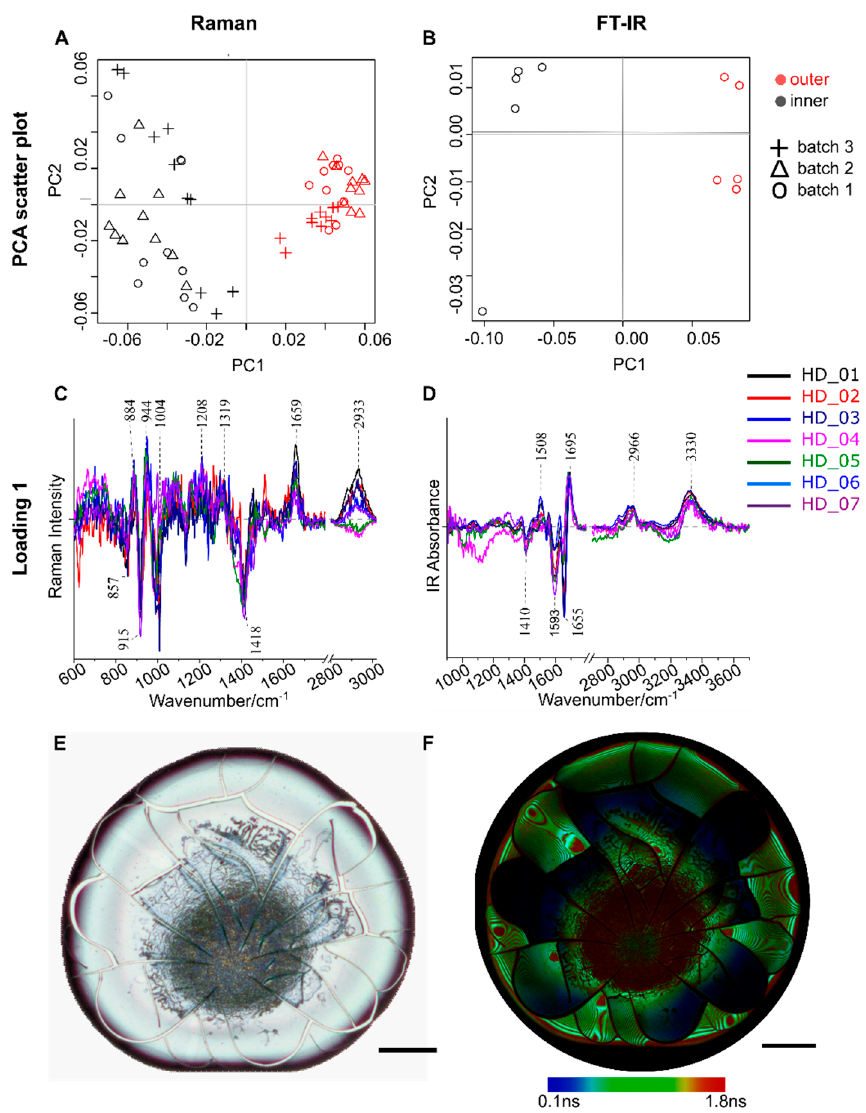
Figure 3. Principal component analysis (PCA) analysis of ( A ) Raman spectra and ( B ) FT-IR spectra collected from inner and outer-ring regions of the dried plasma droplet from a healthy donor (HD). ( n = 1). PCA analysis was performed separately for n = 7 healthy donors; for the sake of space the PCA score plot has been shown for only one healthy donor, whereas the loadings coefficient PC1 obtained for ( C ) Raman and ( D ) FT-IR spectral data for different healthy donors ( n = 7) overlayed on top of each other has been shown for comparison. ( E ) White light image of a healthy donor plasma ( n = 1) shown along with the ( F ) fluorescence lifetime image to illustrate molecules having different lifetimes in the inner and outer-ring regions. Scalebar is 200 µm.